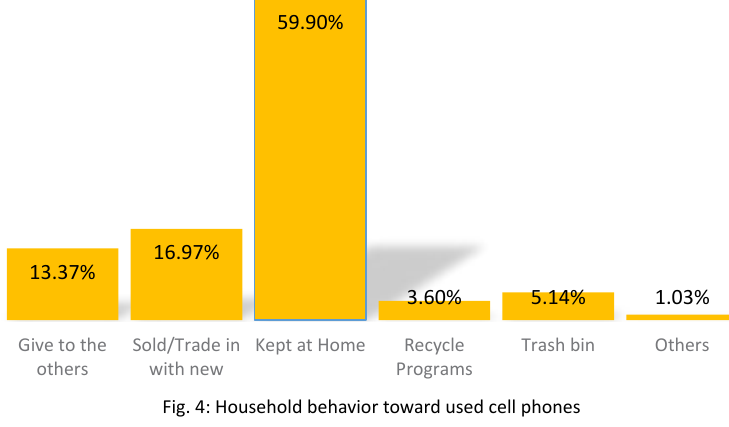
Fig. 4: Household behavior toward used cell phones Fig 4: Household behavior toward used cell phones